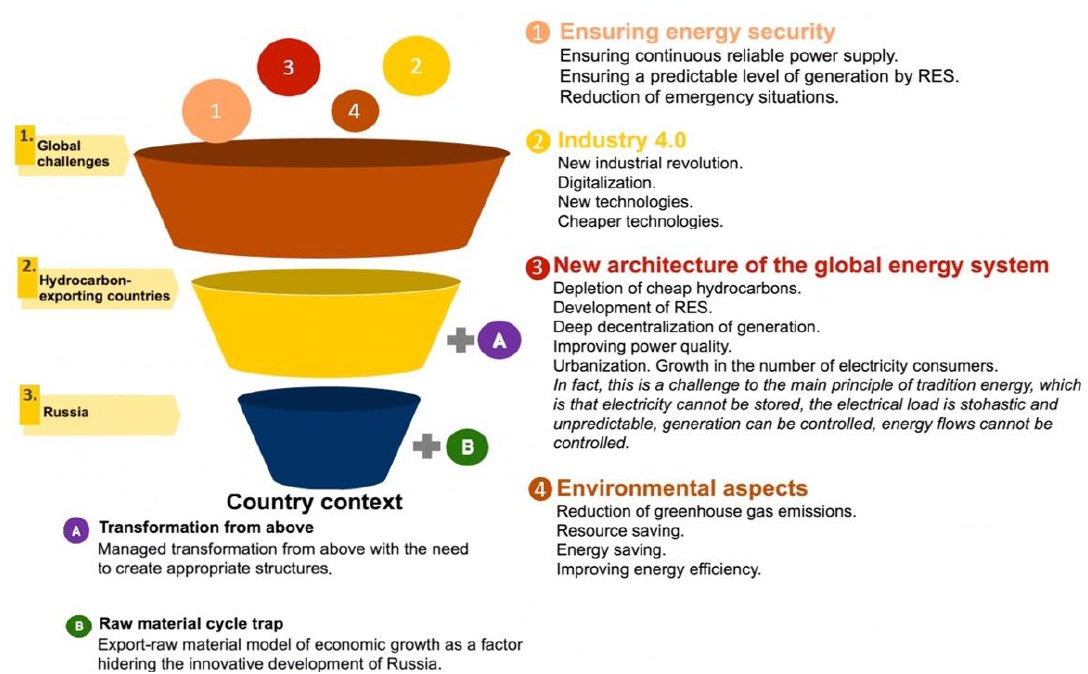
Figure 2. Structure of global and local challenges.